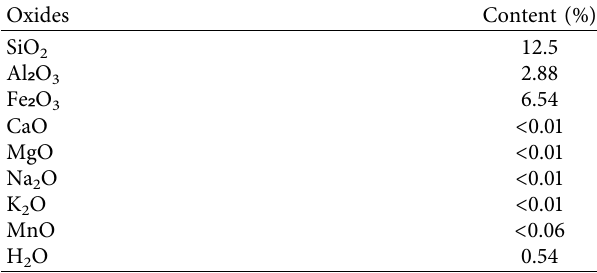
Table 1: Chemical composition of crumb